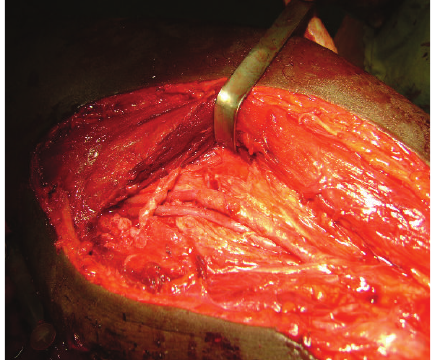
Figure 5: Superficial femoral artery and vein after repair using saphenous vein replacement. We have used the inverted larger portion of the vein to repair the artery and the smaller portion to repair the